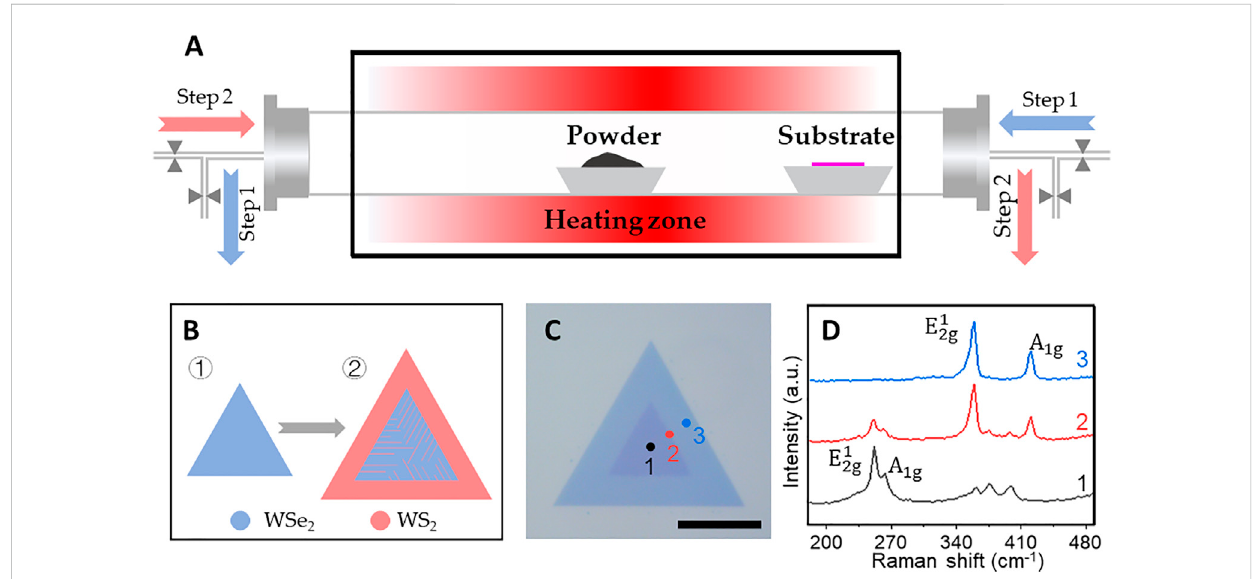
FIGURE 1 CVD synthesis strategy for monolayer WSe 2 growth and WS 2 epitaxial growth. (A) Diagrammatic sketch of the single supply source CVD growth methodwithcontrollableair fl owdirections. (B) DiagrammaticsketchoftheWSe 2 /WS 2 2Dquantumwellsuperlatticesynthesisstrategy. (C)